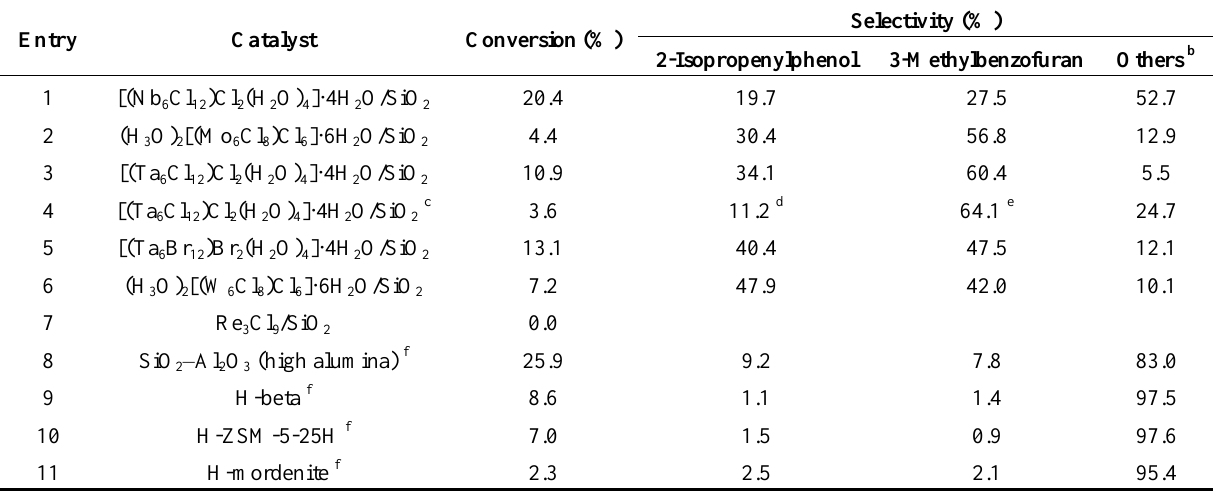
Table 7. Synthesis of 3-methylbenzofuran over halide clusters a